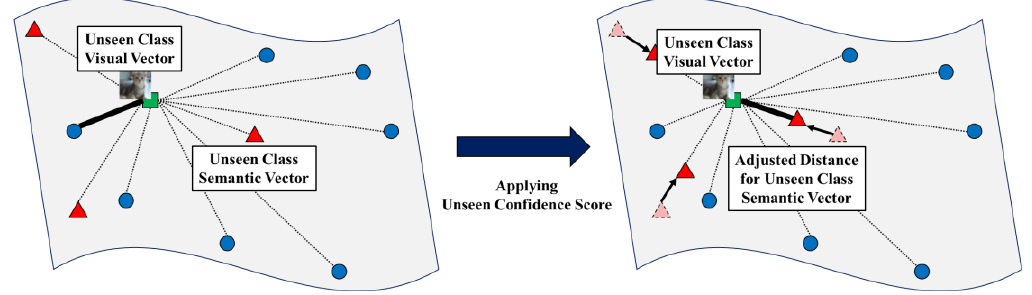
Figure 4. Example of zero-shot inference applying unseen confidence score.